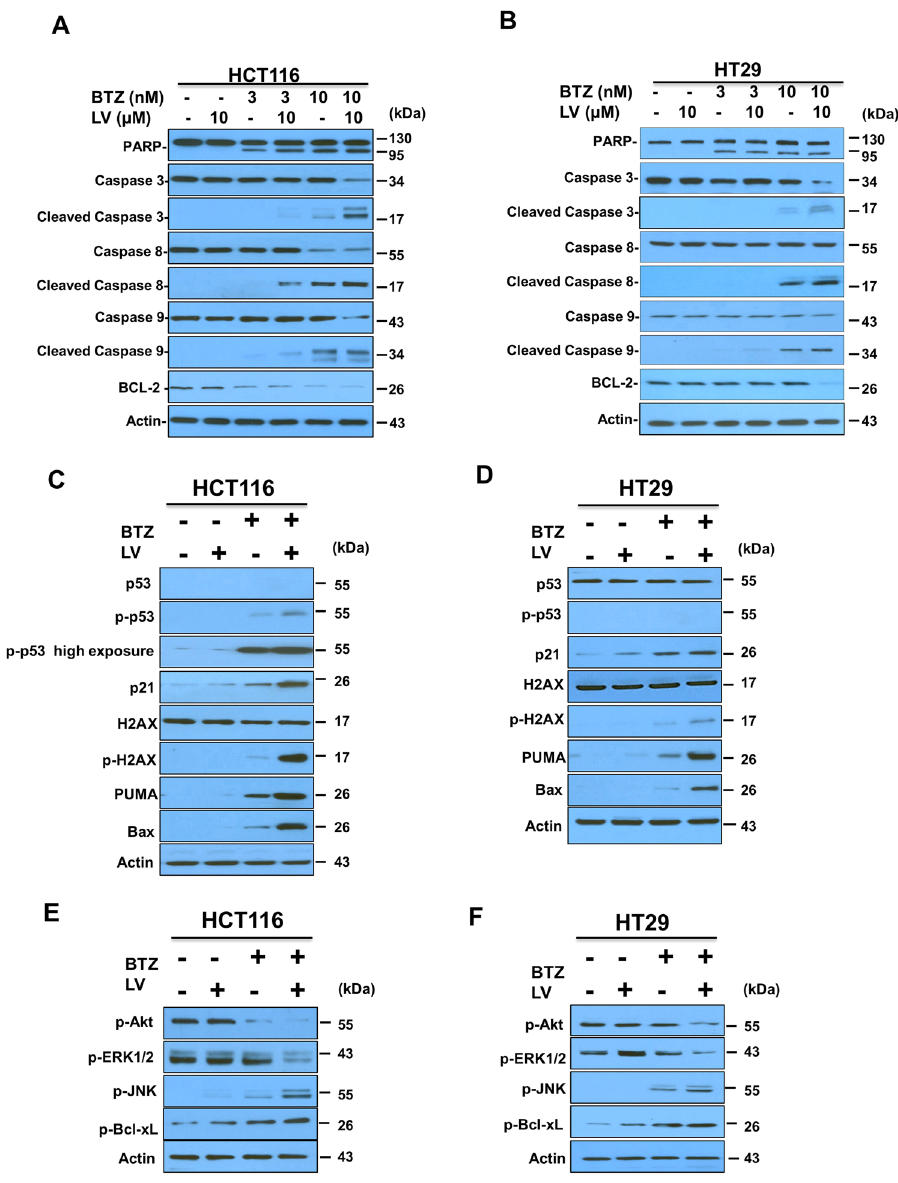
Figure 4. Bortezomib and leucovorin induce activation of caspases and the DNA damage response. HCT116 (A,C,E) and HT29 (B,D,F) cells were treated with bortezomib (3 or 10 nM) and 10 µ M leucovorin or with a single agent for 24 h. Cell lysates were separated by SDS-PAGE and the target protein expression was analyzed by western blotting analysis. Actin was used as a loading control. (A,B) PARP and caspases, (C,D) p53 and its targets, (E,F) kinase